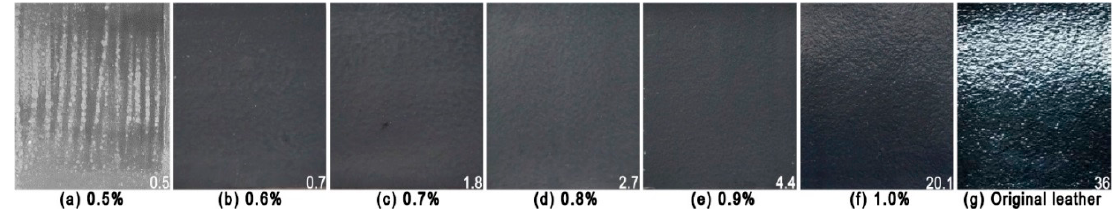
Figure 4. Digital images of leather coated by WPU-A with different AAS contents.